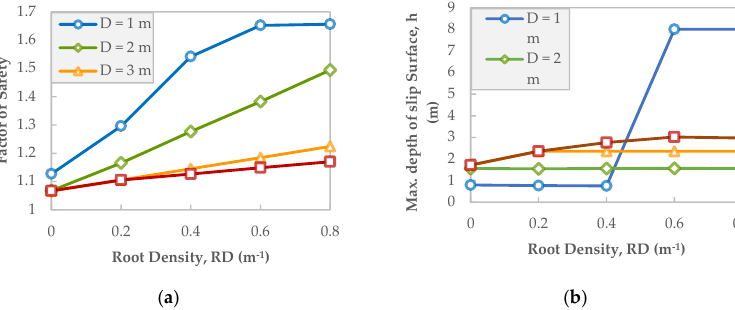
Figure 17. ( a ) The factor of safety and ( b ) the maximum depth of the slip surface for the vegetated slope.